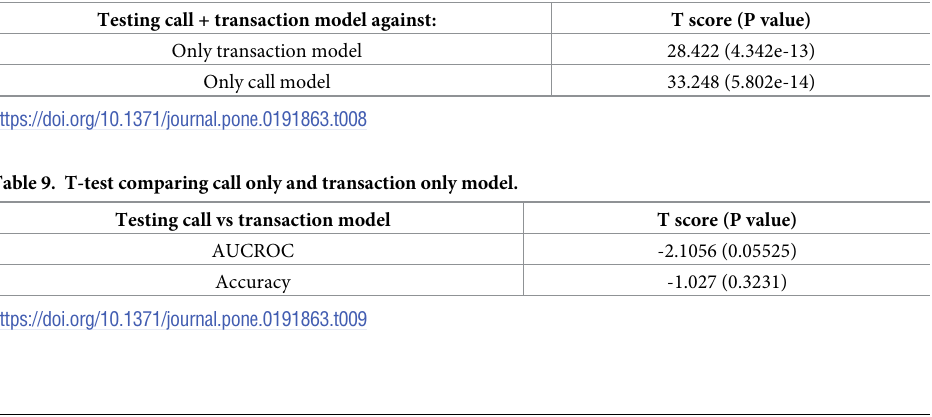
Table 8. T-test for AUCROC.